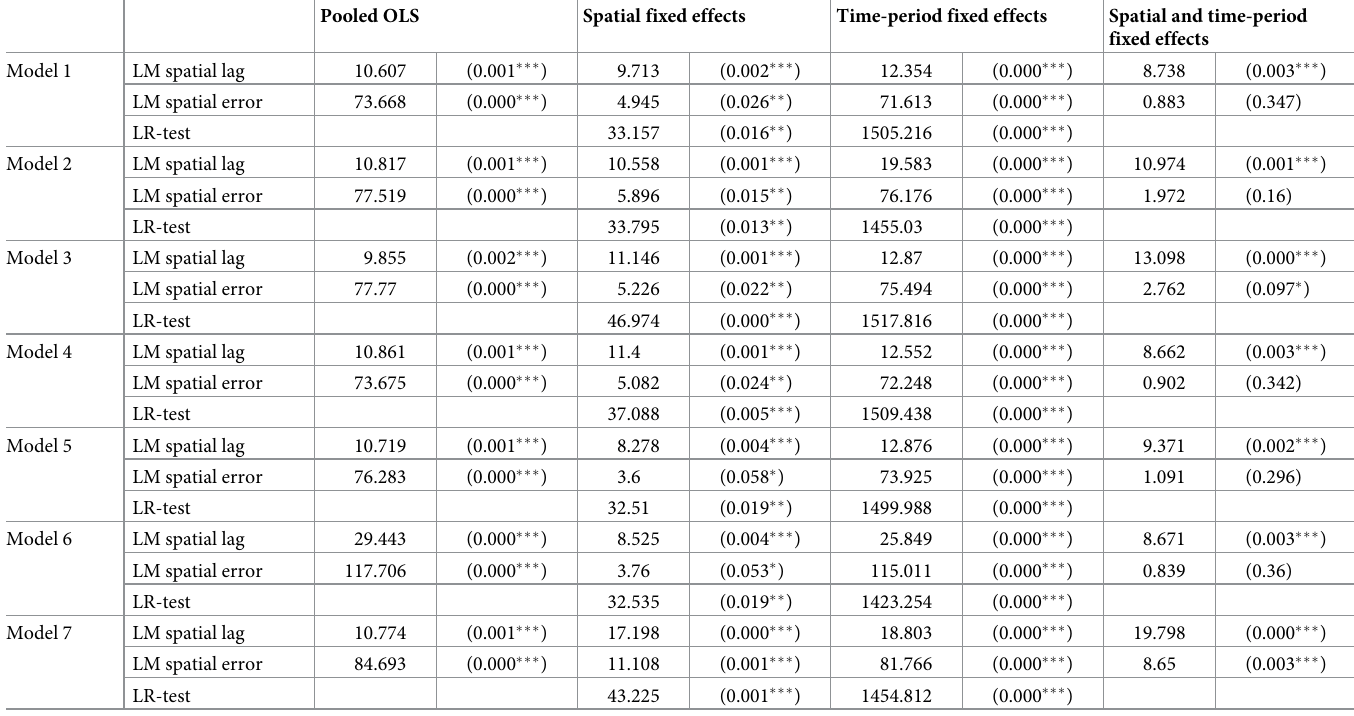
Table 4. The spatial lag or the spatial error in the spatial and time-period fixed effects